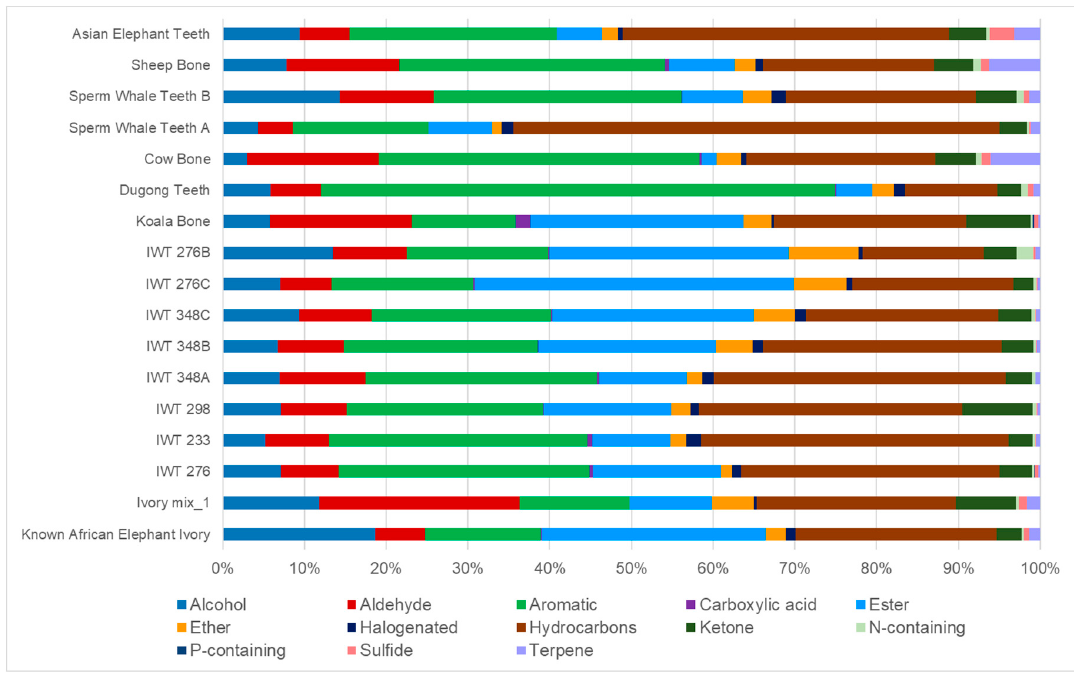
Figure 3. Volatilome profiles by percent compound class.